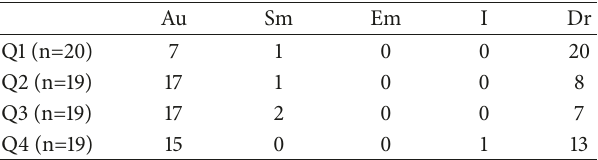
Table 3: Numbers of statements in each